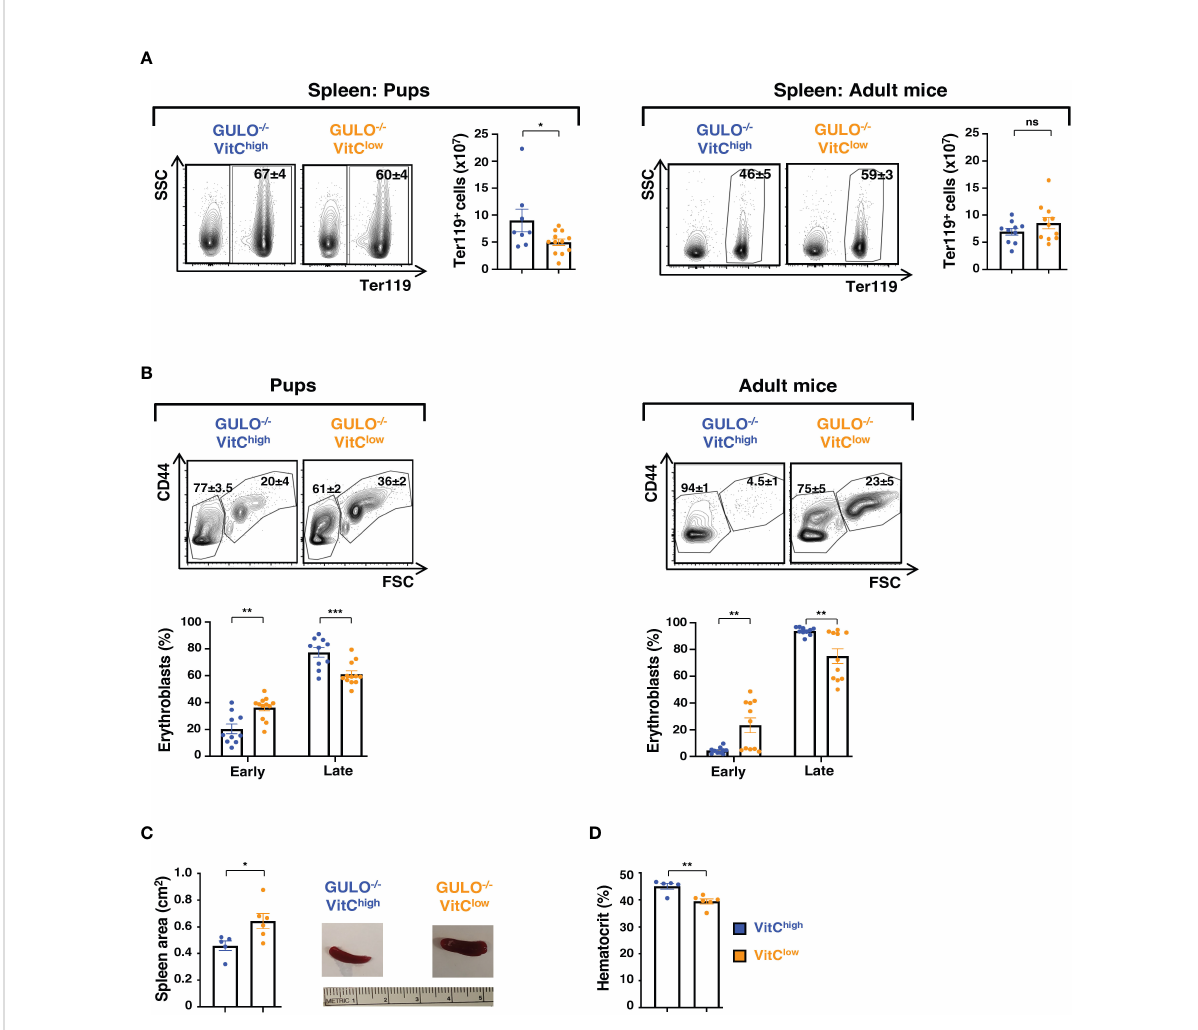
FIGURE 6 Ascorbate de fi ciency is associated with splenic erythropoiesis in GULO -/- mice. (A) Ter119 + cells in the spleen were assessed in GULO -/- pups and adult mice in the indicated conditions. Representative contour plots and quanti fi cations are presented. (B) Within the splenic Ter119 + subset, early (pro, basophilic and polychromatic) erythroblasts were distinguished from late (orthochromatic) erythroblasts, reticulocytes, and RBCs as a function of their CD44/FSC pro fi les. Representative CD44/FSC contour plots and quanti fi cations in individual mice are presented (n=8-12 mice per group). (C) Spleen sizes in adult GULO -/- VitC high and GULO -/- VitC low mice were quanti fi ed as a function of their area (cm 2 ) and means ± SEM (left) as well as representative images are shown (right). (D) Hematocrits in GULO -/- VitC high and GULO -/- VitC low mice were evaluated, and percentages are shown (n=5-6 mice with two replicates). Statistical analyses were performed using an unpaired two-tailed t-test in panels (A, C, D) and a two-way ANOVA (Tukey ’ s test) in panel (B) . *p < 0.05; **p < 0.01; ***p < 0.001; ns, not signi fi